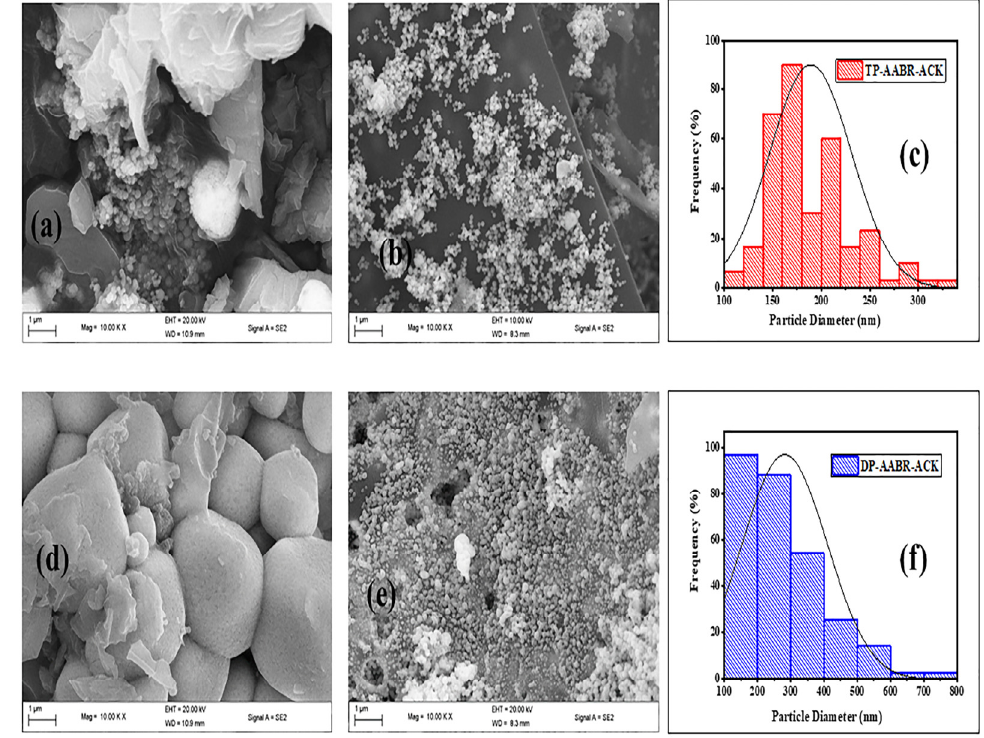
Figure 2. SEM images plasmon: ( a ) TP-AABR, ( b ) TP-AABR-ACK, ( d ) DP-AABR, ( e ) DP-AABR-ACK, and ( c , f ) particle size distribution of TP-AABR-ACK and DP-AABR-ACK photocatalysts.